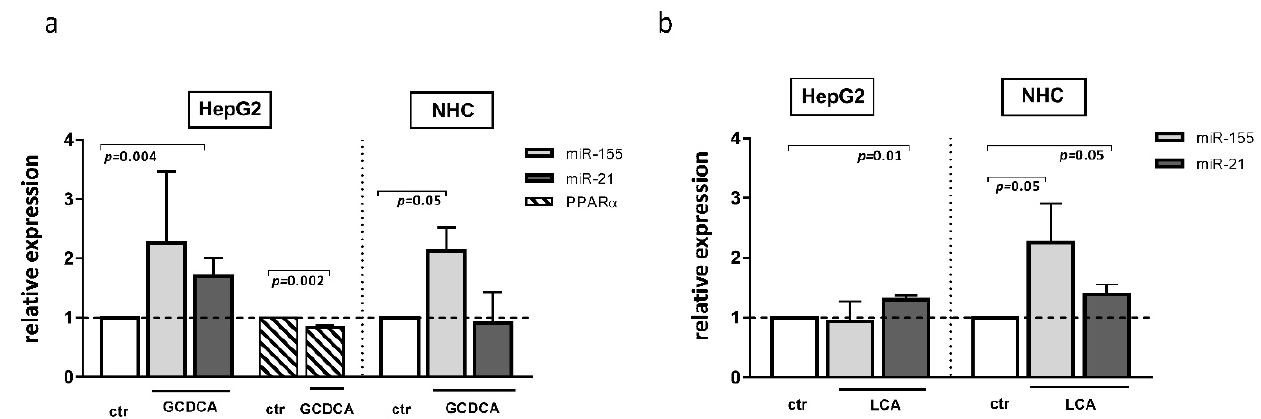
Figure 5. The effect of glycochenodeoxycholic acid (GCDCA) and lithocholic acid (LCA) in human hepatocarcinoma (HepG2) and normal human cholangiocytes (NHC) cells. In HepG2 cells, both GCDCA ( a ) and LCA ( b ) induced miR-21. In NHC cells, both bile acids induced miR-155, whereas miR-21 was enhanced only after LCA stimulation. The PPAR α level was reduced in HepG2 after GCDCA treatment ( a ). Each experiment was repeated at least three times. MiR-16 was used as an endogenous reference for miRNA or 18S RNA for other genes. Bars indicate the mean ± SEM. A Student’s t -test were used for a quantitative data analysis.